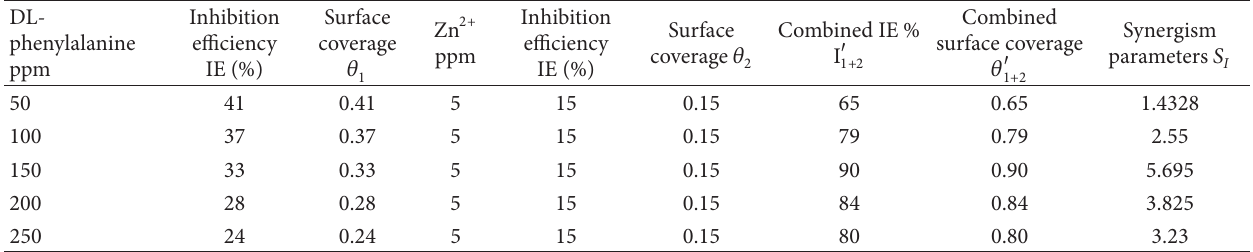
T 4: Inhibition efficiencies and synergism parameters for various concentrations of DL-Phe-Zn immersed in well water.